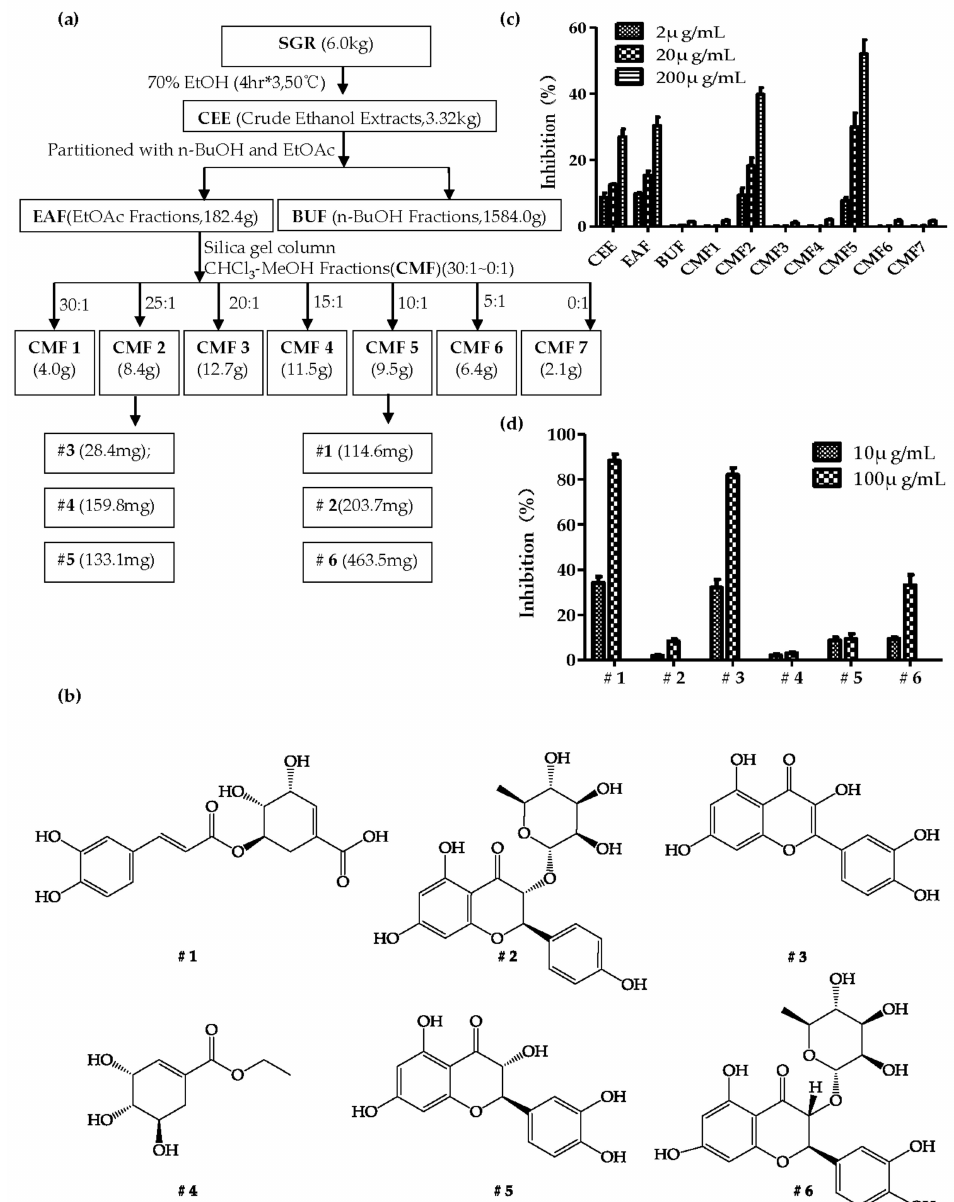
Figure 1. Bio-assay guided fractionation and isolation from SGR. Schematic isolation procedures of fractions and compounds from SGR were described in ( a ). Structures of the chemicals ( #1–6 ) were shown in ( b ). Inhibition rates of 10 fractions ( c ) and 6 compounds ( d ) on XOD were evaluated and plotted by Graphpad. Values were presented as mean ± SEM of five replicates. SGR: Smilacis Glabrae Rhizoma ; CEE: Crude Ethanol Extracts; EAF: EtOAc Fractions; BUF: n-BuOH Fractions; CMF: CHCl 3 -MeOH